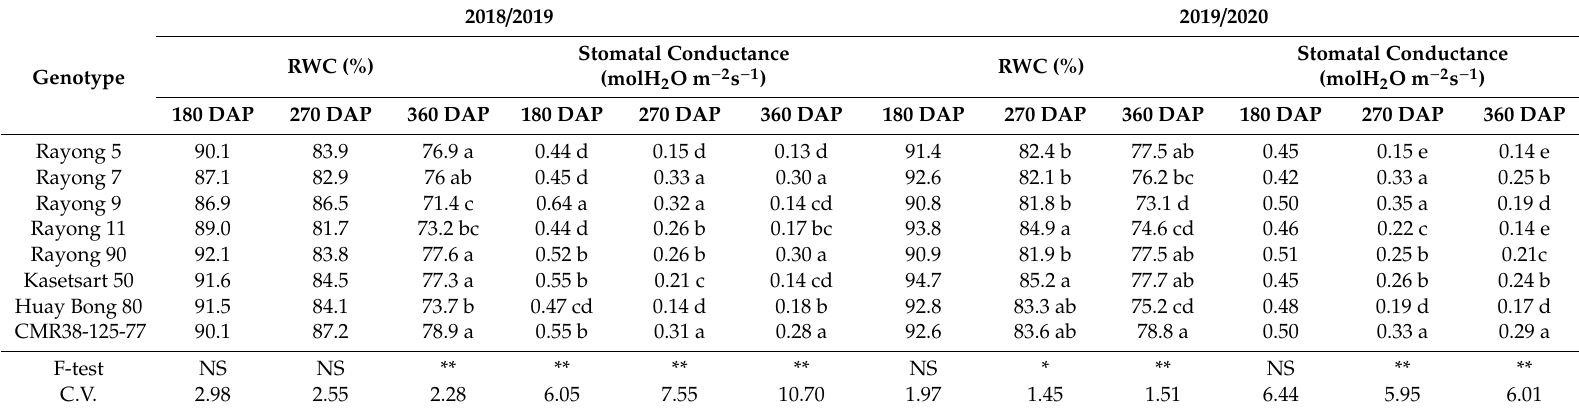
Table 4. Relative water content for leaf (RWC) and stomatal conductance at di ff erent days after planting (DAP) for eight cassava genotypes grown in 2018 / 2019